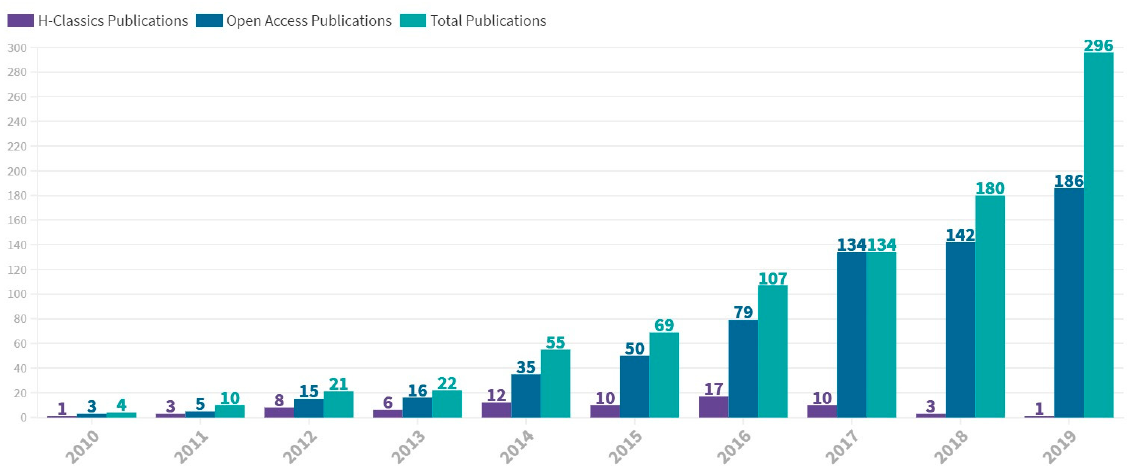
Figure 1. Annual scientific production in mass cytometry between 2010 and 2019. Number of H-Classics publications, open access publications and total publications are represented. The figure was designed with Flourish.